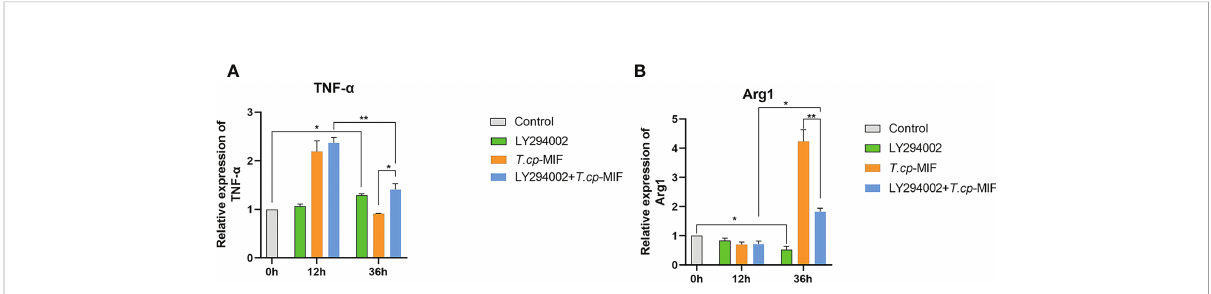
FIGURE 11 The effect of LY294002 on the expression of TNF- a and Arg1. (A) the expression of TNF- a . (B) the expression of Arg1. * indicated P <0.05, ** indicated P <0.01. Results are showed as the mean of three times of independent experiments ( x ̄ ±SD,